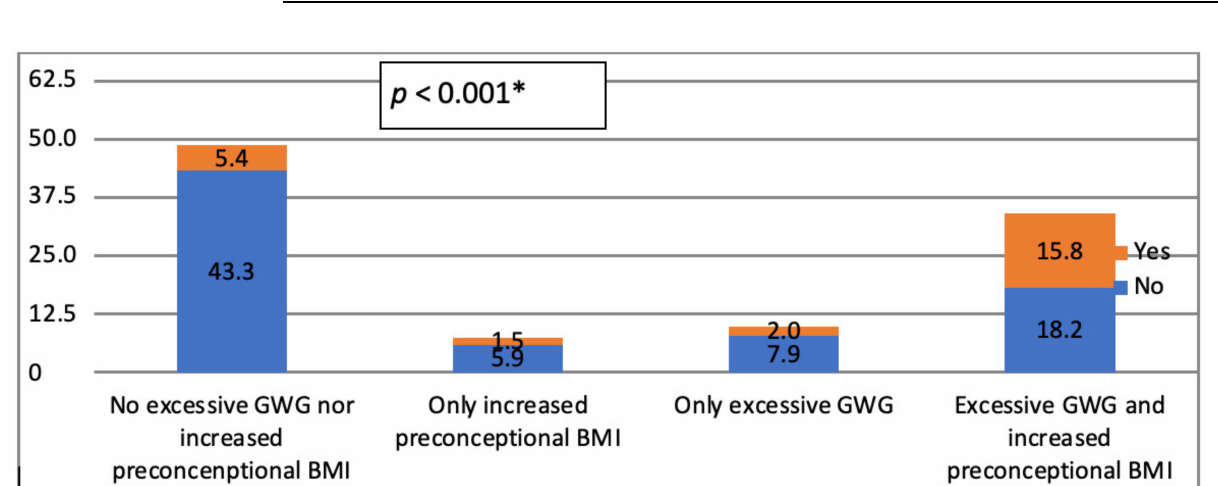
Figure 1. Frequencies of excessive GWG and increased pre-pregnancy BMI with regards to the presence of GDM in study group. * Chi-square test; GWG: Gestational Weight Gain; BMI: Body Mass Index; GDM: Gestational Diabetes